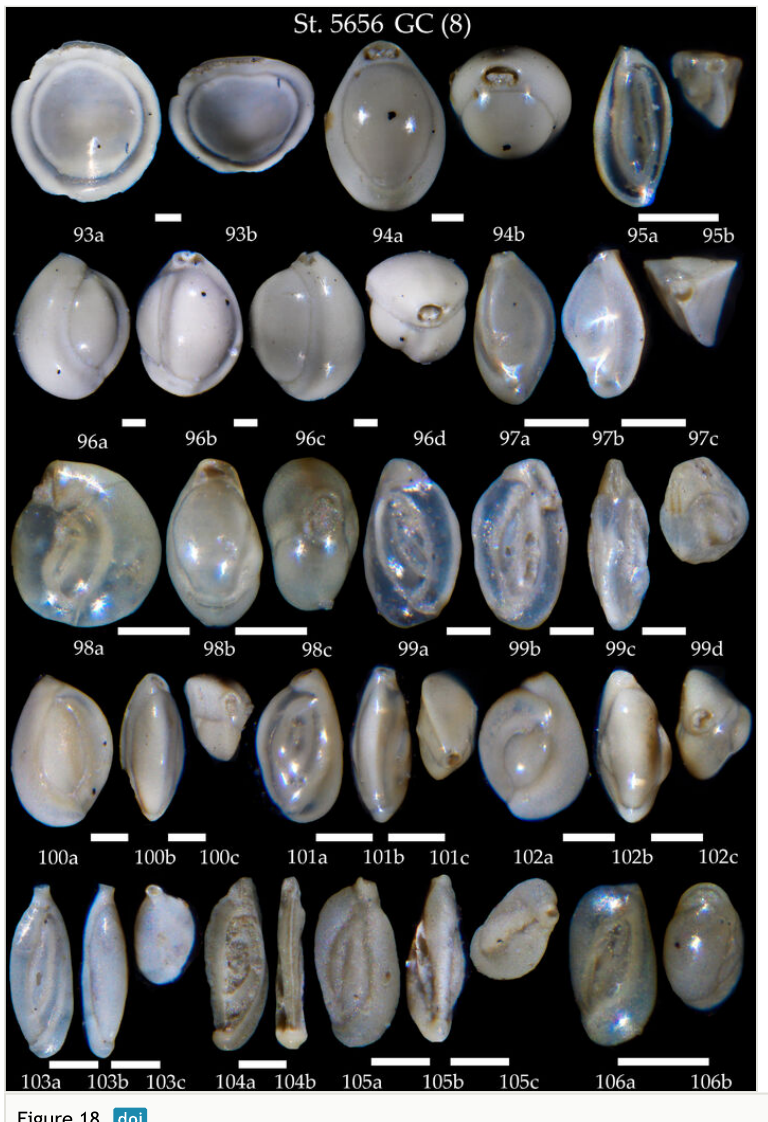
Figure 18. Station 5656 GC (continued). 93 Pyrgo murrhina , a side view, b apertural view; 94 Pyrgo williamsoni , a side view, b apertural view; 95 Triloculina elongata , a side view, b apertural view; 96 Triloculina trigonula , a-c side view, d apertural view; 97 Triloculina trihedra , a, b side view, c apertural view; 98 Miliolinella subrotunda , a, b side view, c apertural view; 99 Massilina secans , a-c side view, d apertural view; 100 Quinqueloculina seminulum , a, b side view, c apertural view; 101 Quinqueloculina sp. cf. Q. seminulum ; 102-106 Quinqueloculina sp. Scale 100